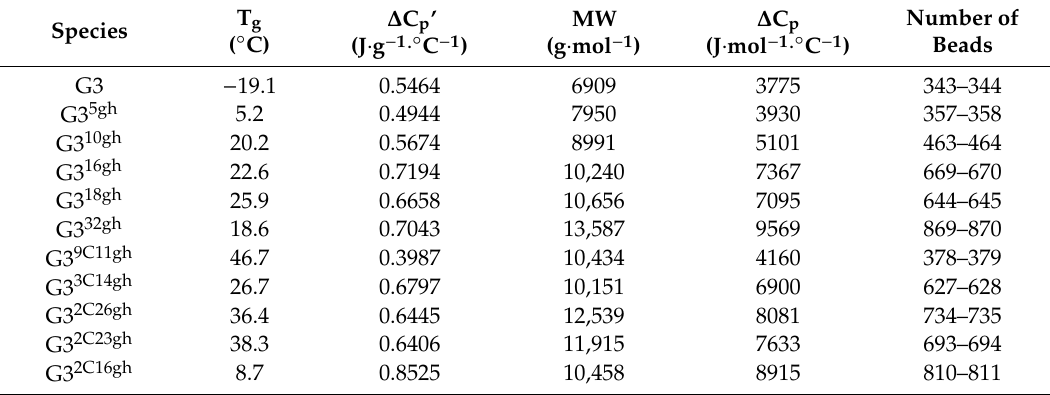
Figure 8. Comparison of heat-flow rates of G3 Cgh conjugates versus temperature. Table 3. The di ff erential scanning calorimetry (DSC) results and obtained parameters: ∆ C p was obtained at T g